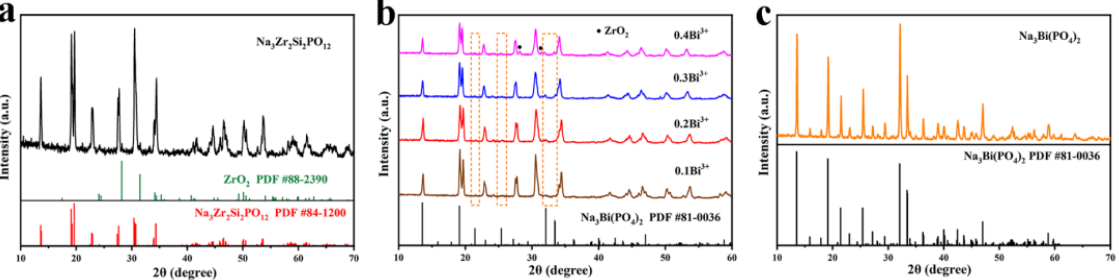
Figure 1. XRD patterns of ( a ) Na 3 Zr 2 Si 2 PO 12 , ( b ) Na 3 Zr 2 Si 2 PO 12 - x Bi ( x = 0, 0.1, 0.2, 0.3 and 0.4) and ( c ) Na 3 Bi(PO 4 ) 2 .